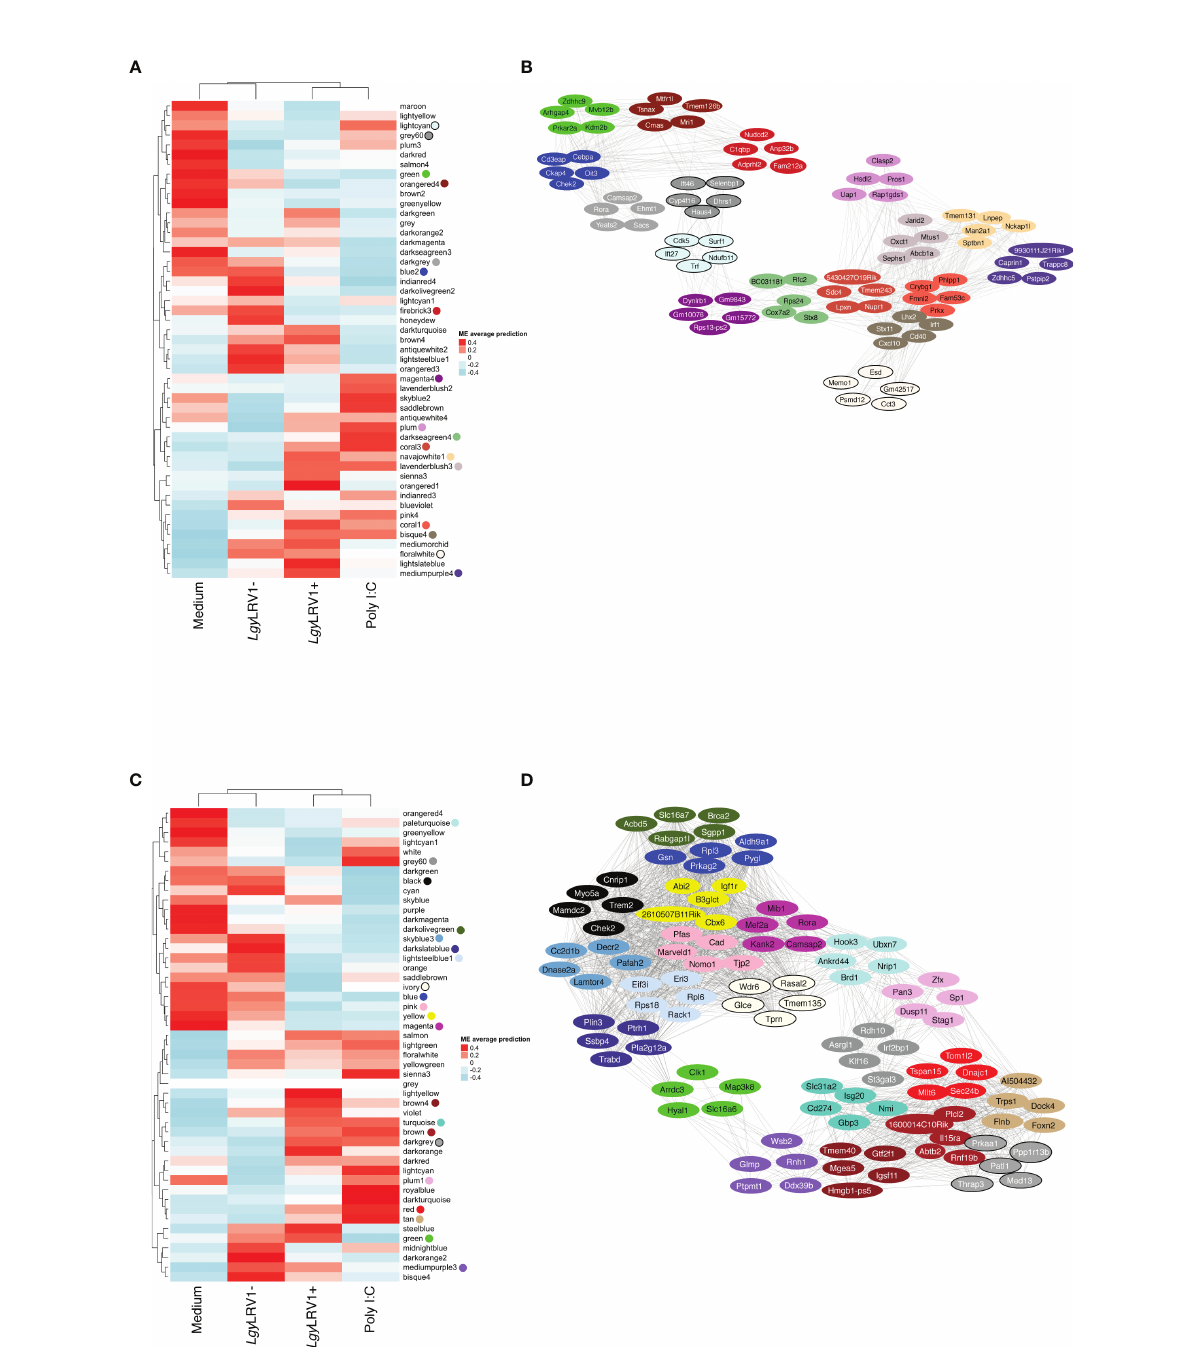
FIGURE 2 The global network analysis of WT-infected macrophages highlights modules and key pathways associated to Leishmania and to Leishmania RNA virus 1 (LRV1). (A) Heatmap of the average predictions of the fi tted linear model on each module eigengene (ME) at the 8-h time point. (B) Network generated from selected modules at the 8-h time point associated with Leishmania infection ( Lgy LRV1+, Lgy LRV1-), virus ( Lgy LRV1+, poly I:C), and “ exacerbatory ” modules. Only the top fi ve highest connected genes were selected. Node colors indicate the module color they belong to. Edges between genes indicate the correlation between genes. (C) Heatmap of average predictions of the fi tted linear model on each ME at the 24-h time point. (D) Network generated from selected modules at the 24-h time point associated with Leishmania infection ( Lgy LRV1+, Lgy LRV1-), virus ( Lgy LRV1+, poly I:C), and “ exacerbatory ” modules. Only the top fi ve highest connected genes were selected. Node colors indicate the module color they belong to. Edges between genes indicate the correlation between